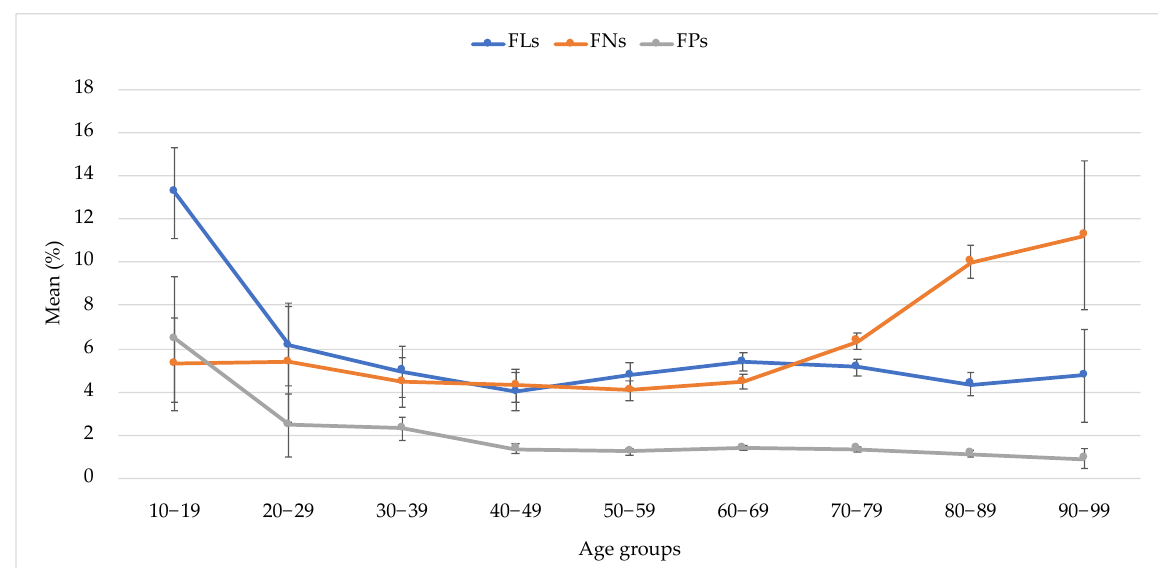
Figure 2. Mean values of FLs, FNs, and FPs in each age-stratified group. FLs, fixation losses; FNs, false negatives; FPs, false positives.